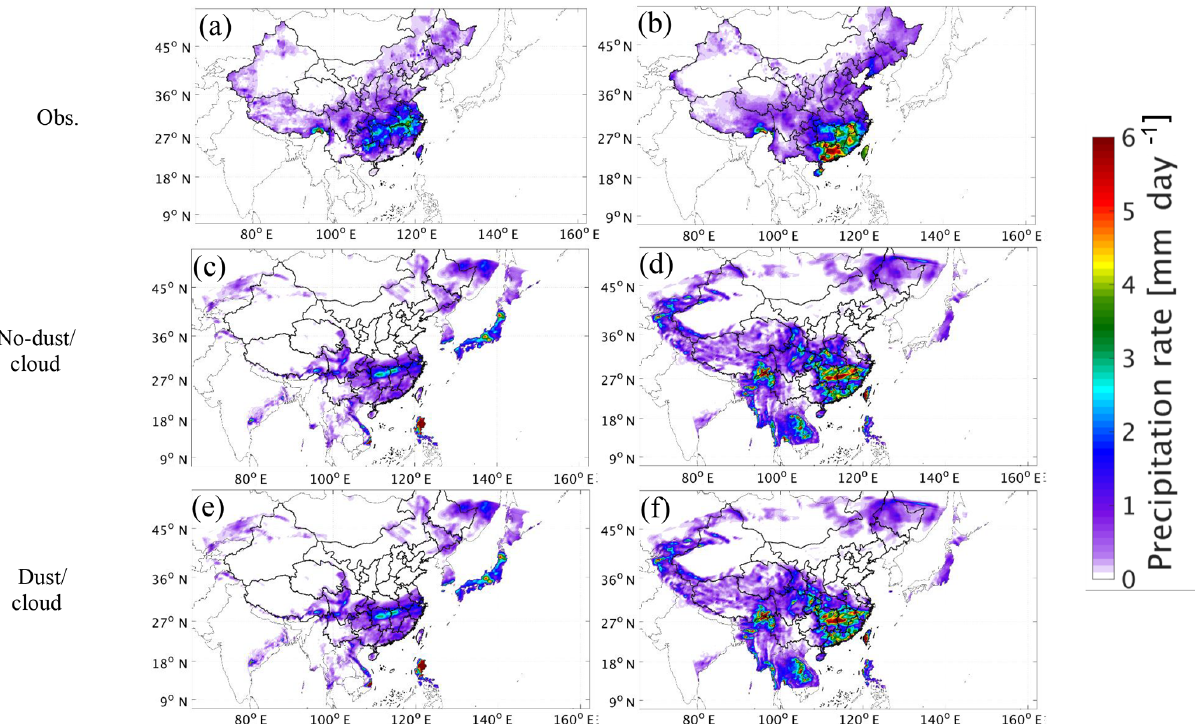
Figure 4. Spatial distributions of the average precipitation rate from observations (a, b) , from NO-DUST/CLOUD (c, d) , and from DUST/CLOUD (e, f) during March (left panels) and April (right panels) 2012.